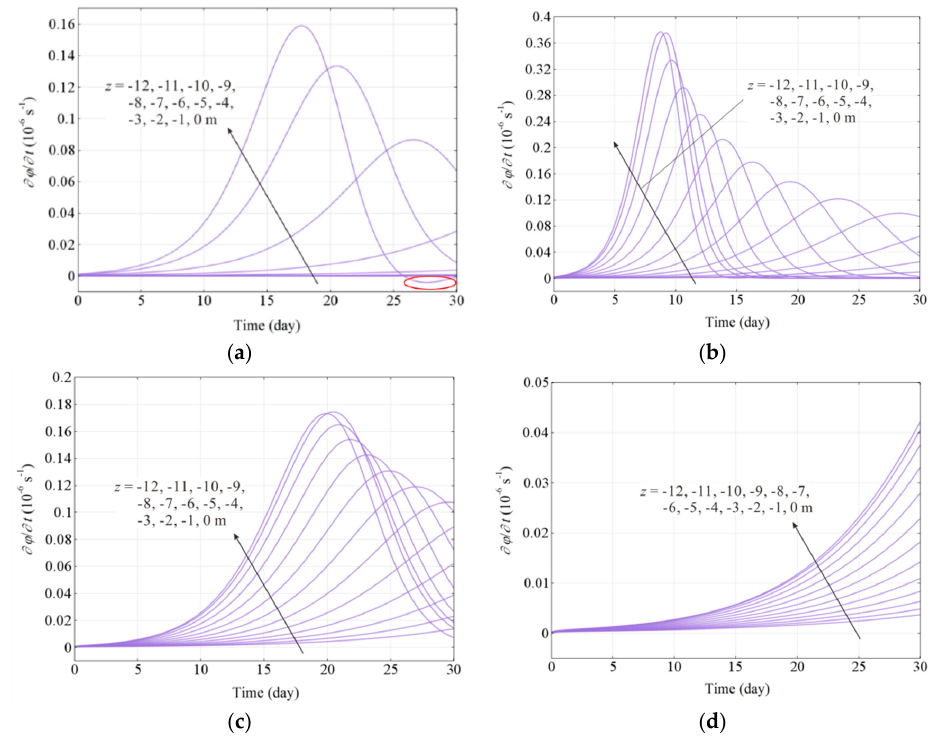
Figure 15. Variations of s. 305